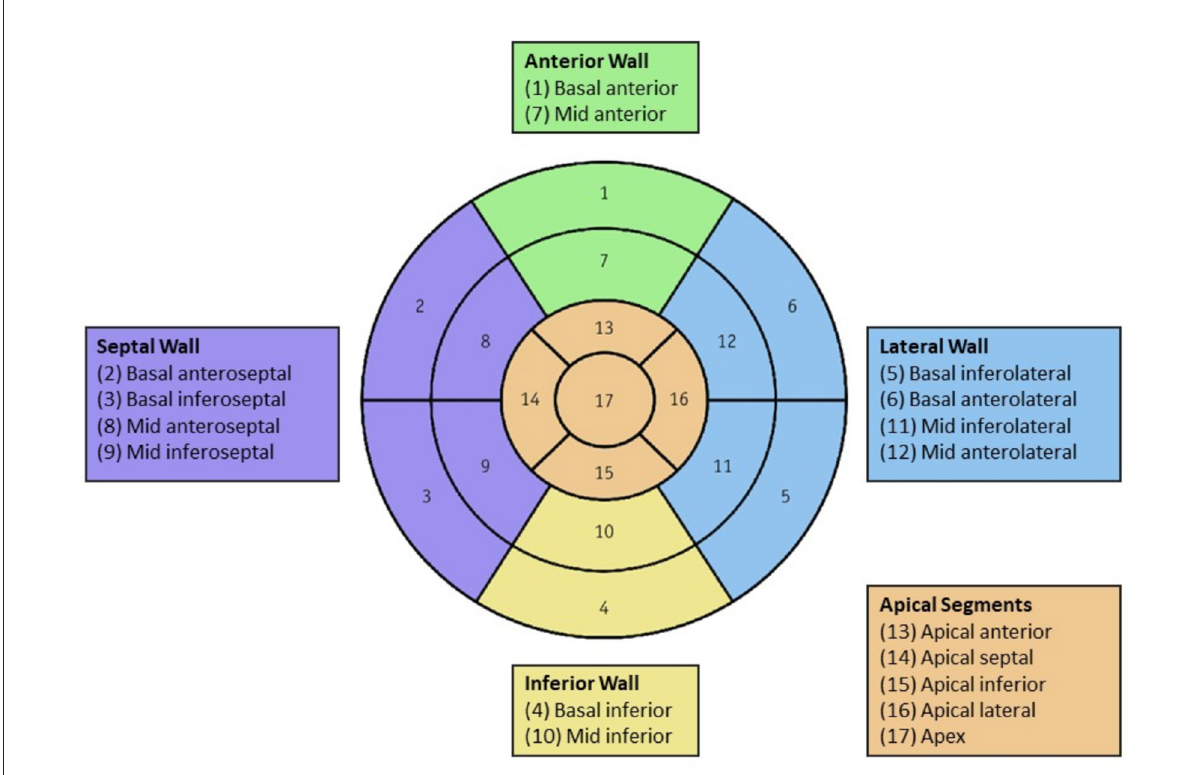
FIGURE1 Left ventricular segmentation: The 17-segment left ventricle model as defined by the American Heart Association distributed into five larger segments: anterior (1, 7), lateral (5, 6, 11, 12), inferior (4, 10), septal (2, 3, 8, 9), and apical (13–17). Color should be used for